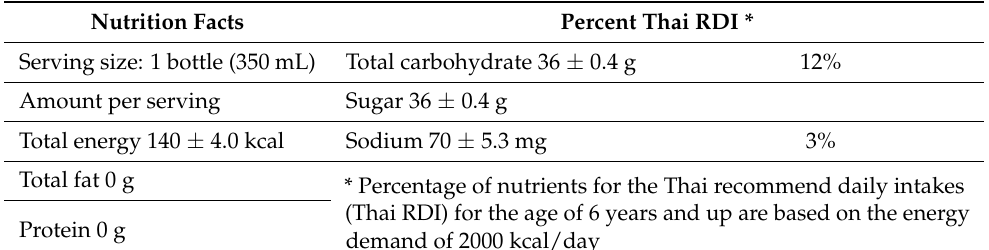
Table 4. The nutrition facts for the beverage containing the aqueous extracts of banana inflorescence.